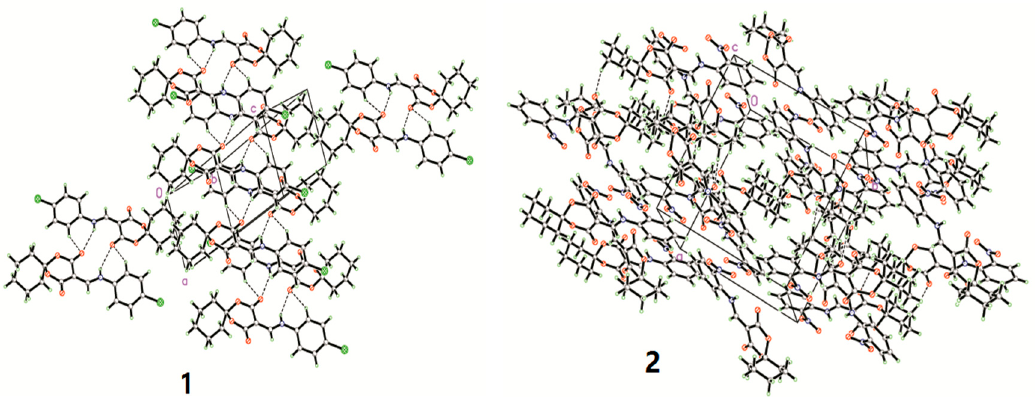
Figure 1. The molecular structures of 1 and 2 with atomic numbering scheme. Crystals 2016 , 6 , 69